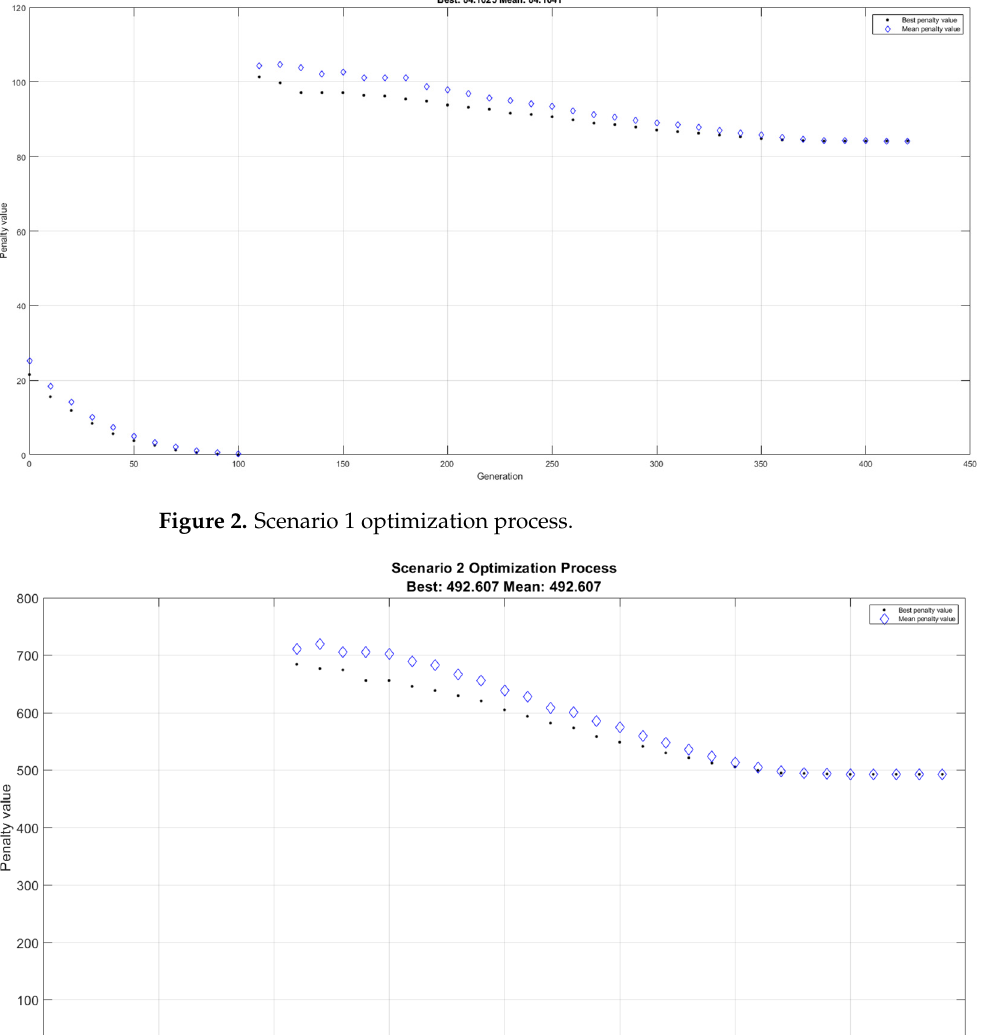
Figure 3. Scenario 2 optimization process .